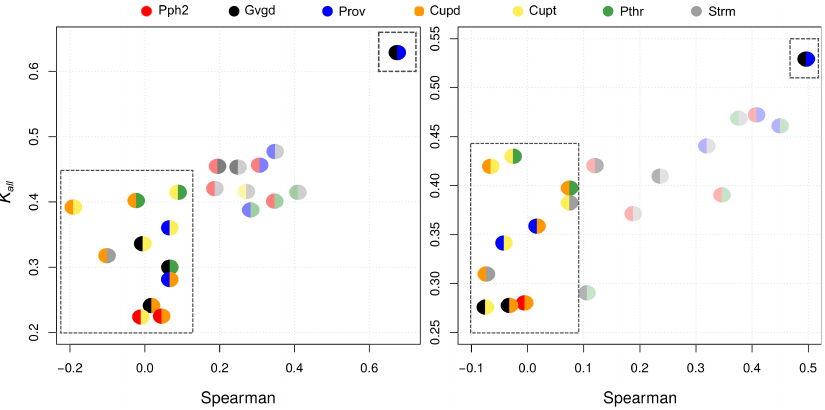
Figure 2. K all vs. Spearman for the BRCA1-SGE ( left ) and BRCA1-HDR ( right ) datasets. The top-right rectangles point out the most correlated p-toleftols. The bottom-left rectangles point out the Cupsatt/d